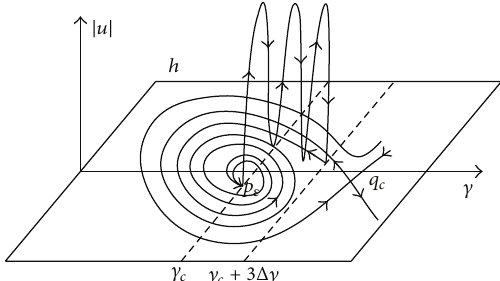
Figure 4: The Shilnikov type three-pulse homoclinic orbits are